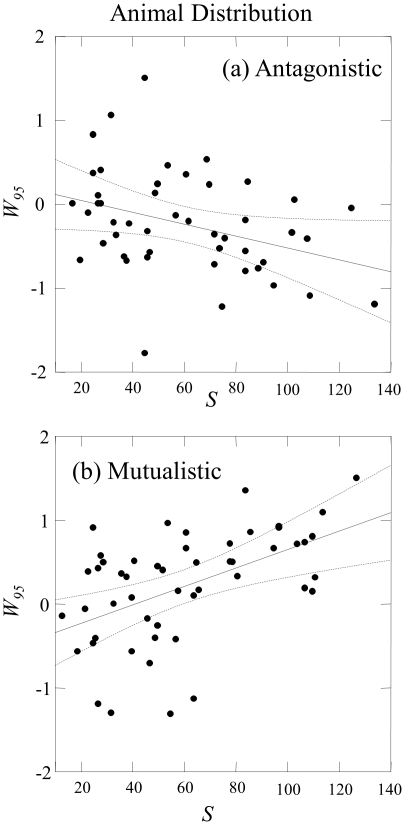
Relative width W95 versus number of species S for the animal distributions of (a) antagonistic networks and (b) mutualistic networks with S<135.Solid line is linear regression, dotted lines are upper and lower confidence intervals. In (a) R2 = 0.25, p<0.001, in (b) R2 = 0.10, p = 0.015.